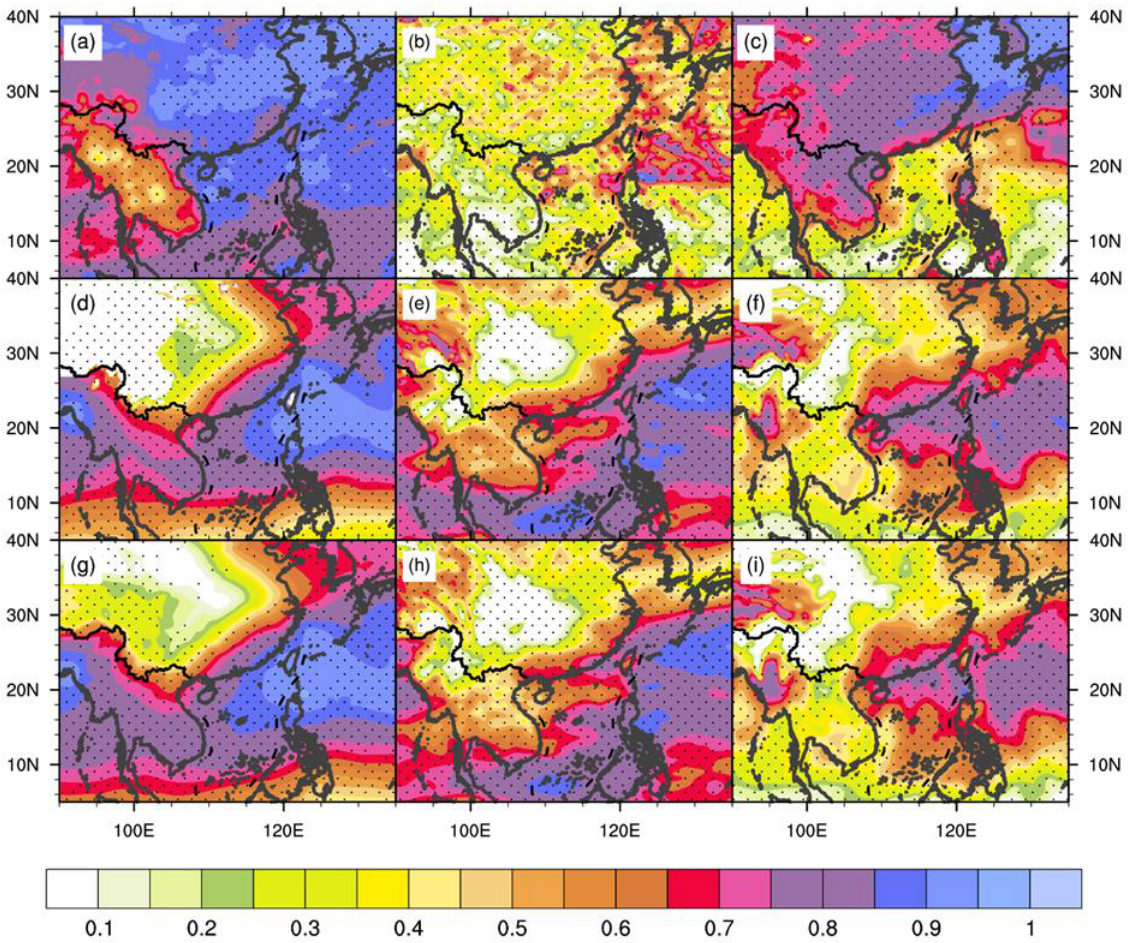
Figure 3. The temporal ACC (contour) of simulation from CTL test and ERA5 reanalysis datasets on ( a ) specific humidity at 700 hPa (unit: 10 − 3 kg/kg), ( b ) precipitation rate (unit: mm/day), ( c ) temperature at 2 m (unit: K), ( d , g ) the geopotential height (unit: gpm), ( e , h ) zonal wind, and ( f , i ) meridional wind at 850 hPa (the second row) and 500 hPa (the third row). Dotted area indicate that the values passed the significant test at a level of 90%.